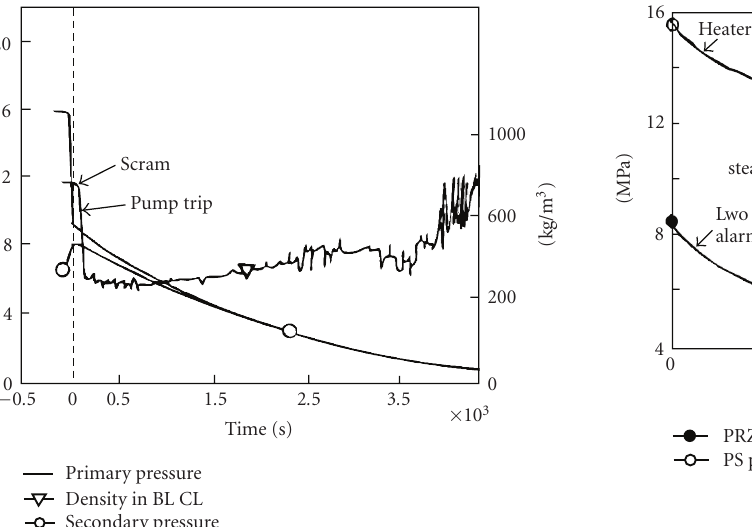
Figure 3: ISP-20 (Doel-2): registered data trends of primary side pressure and pressurizer